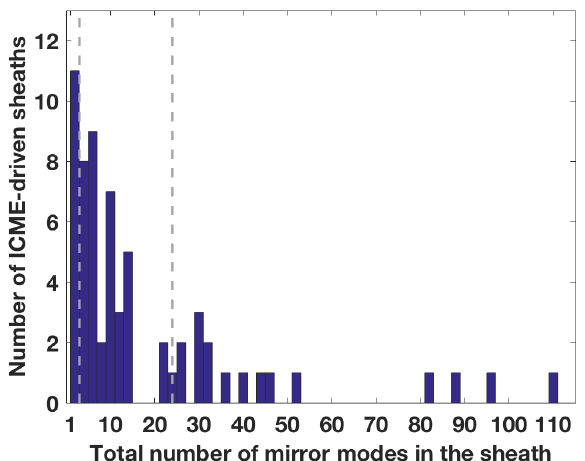
Figure 3. The frequency histogram of ICME-driven sheaths as a function of number of MMs within the sheath in bins of 2 MMs. The grey dashed lines show the lower (3) and upper (24) quartiles of the number of